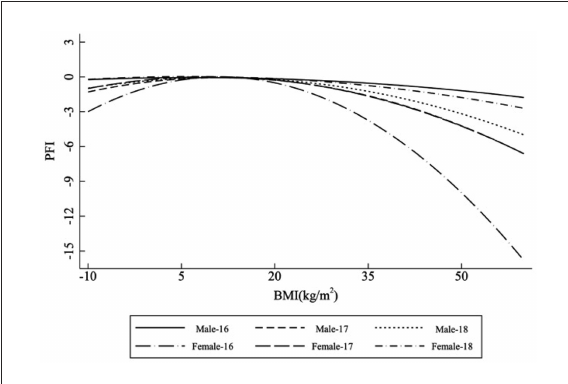
FIGURE2 The relationship between PFI and BMI is grouped by gender and